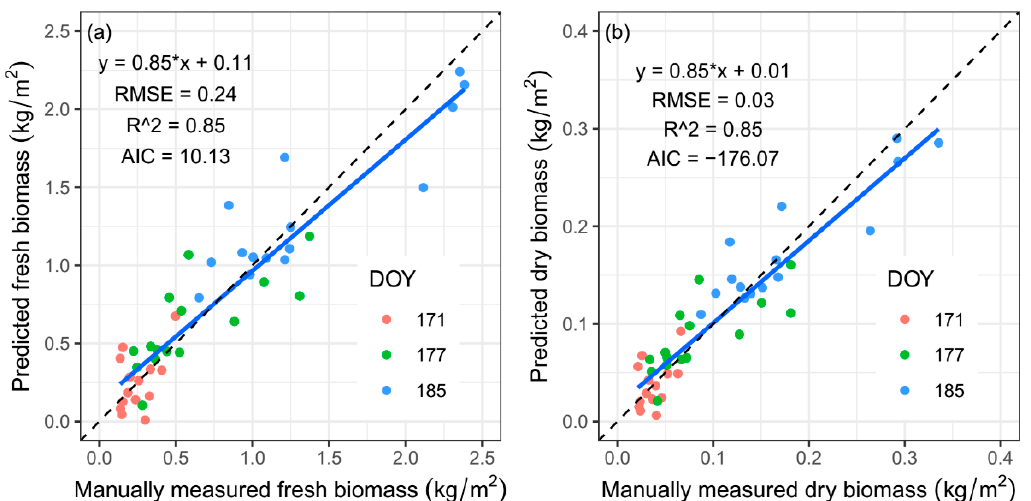
Figure 9. Correlations between maize above-ground biomass estimated based on NGRDI, ExGR, VEG, and plant height by using multivariable linear regression analysis and ground-truth above-ground biomass; ( a , b ) were maize fresh and dry above-ground biomass, respectively.